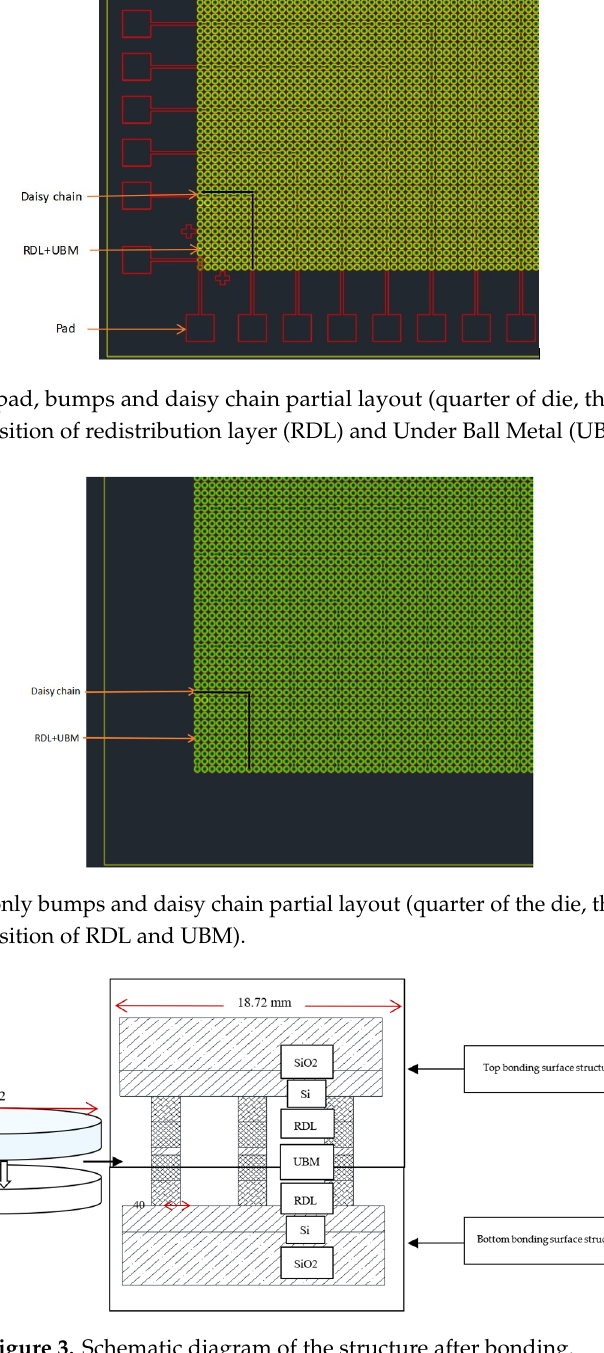
Figure 3. Schematic diagram of the structure after bonding.